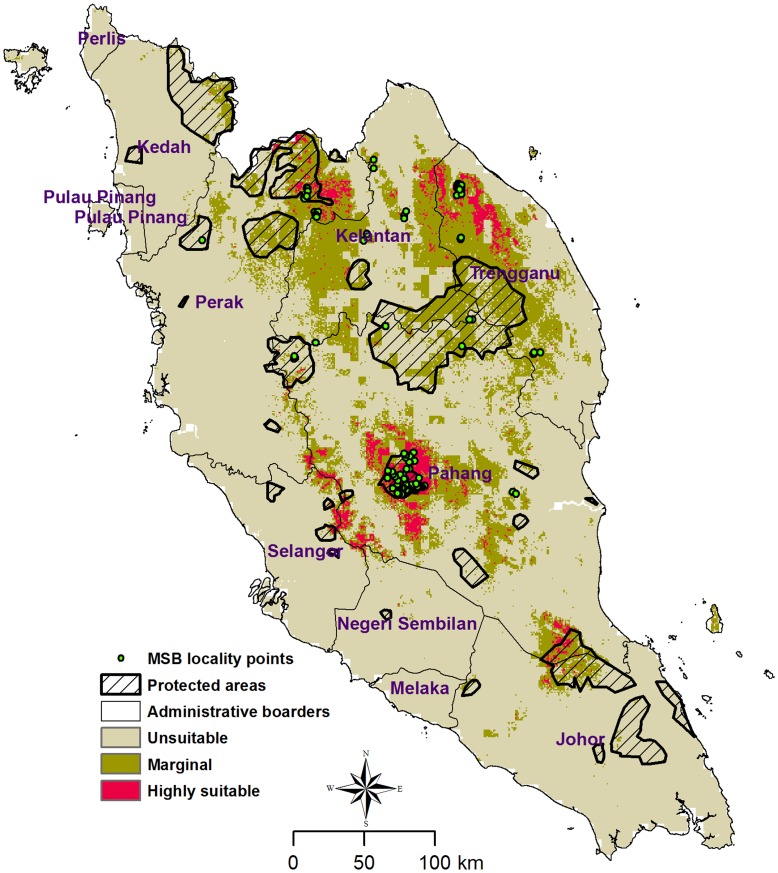
Predicted potential suitable habitat for Malayan Sun Bear (MSB) with the protected area boundaries as well as locational data used for the modeling.